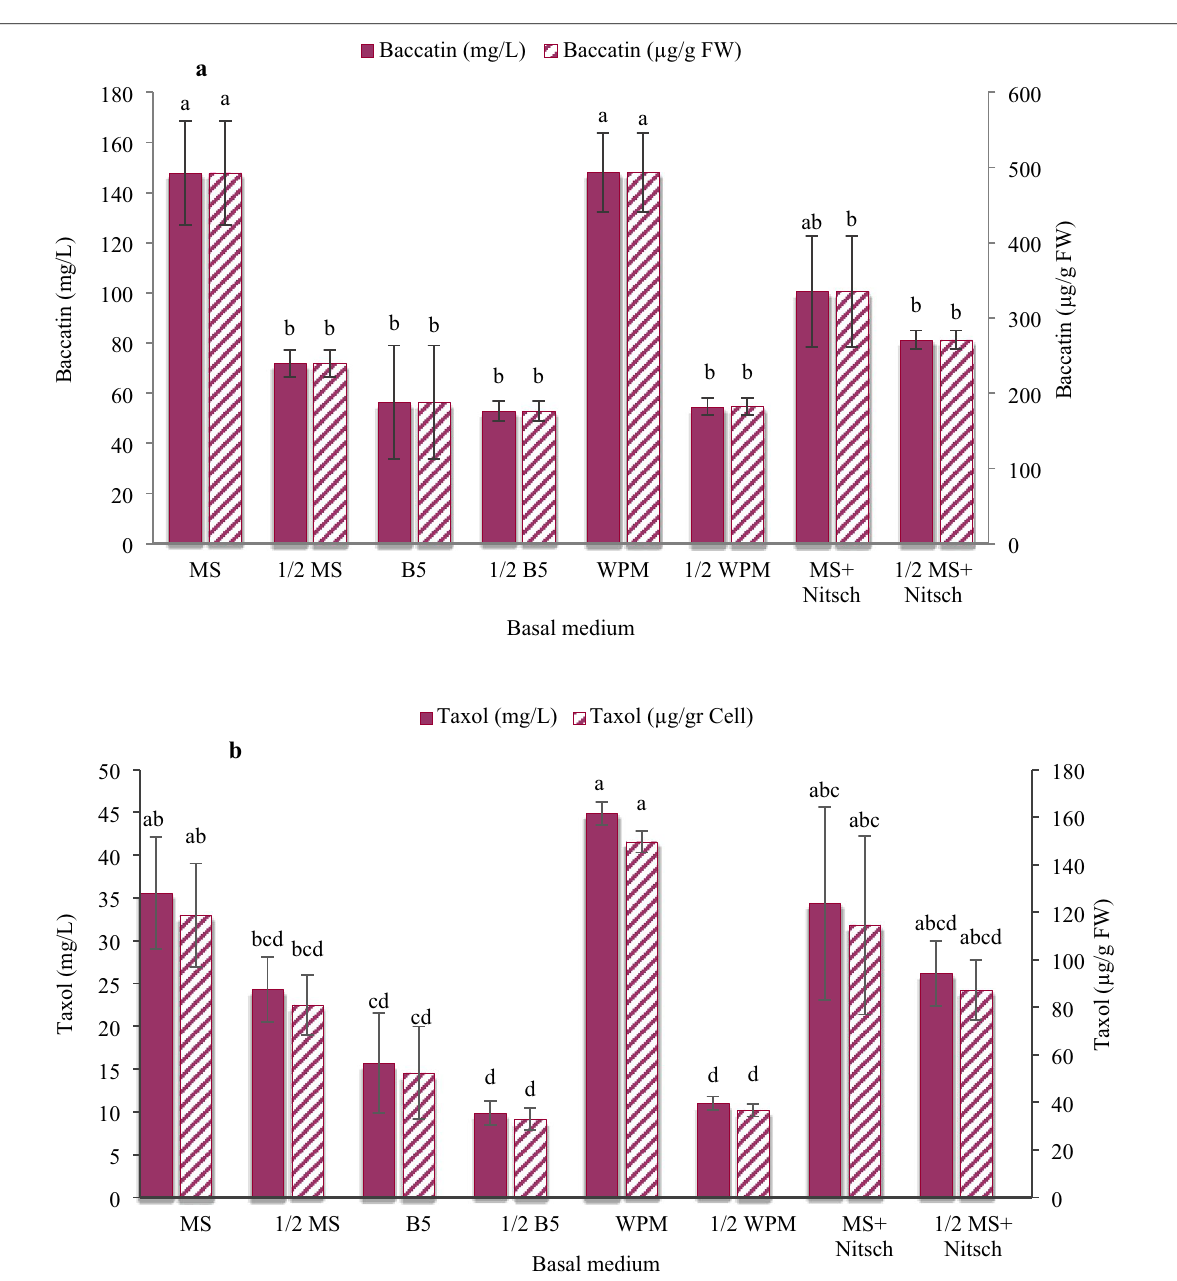
Fig. 4 Content of baccatin III ( a ) and taxol ( b ) in the Corylus avellana cells cultured on the different basal media. According to Duncan’s multiple range tests, values with common letters are not significantly different at the 5% probability level